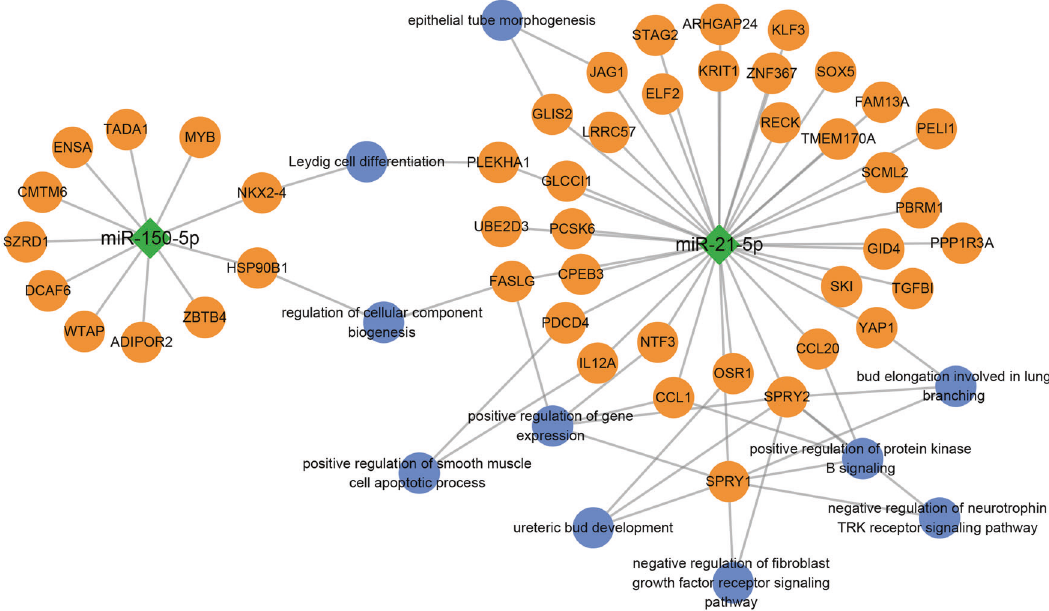
Fig. 5 Gene target network of miR-21-5p and miR-150-5p in pathways of relevance to sepsis and SIC. The green diamond represents miRNA; the orange circle represent the target genes of the miRNA; the blue circle represent functional annotations for target genes.